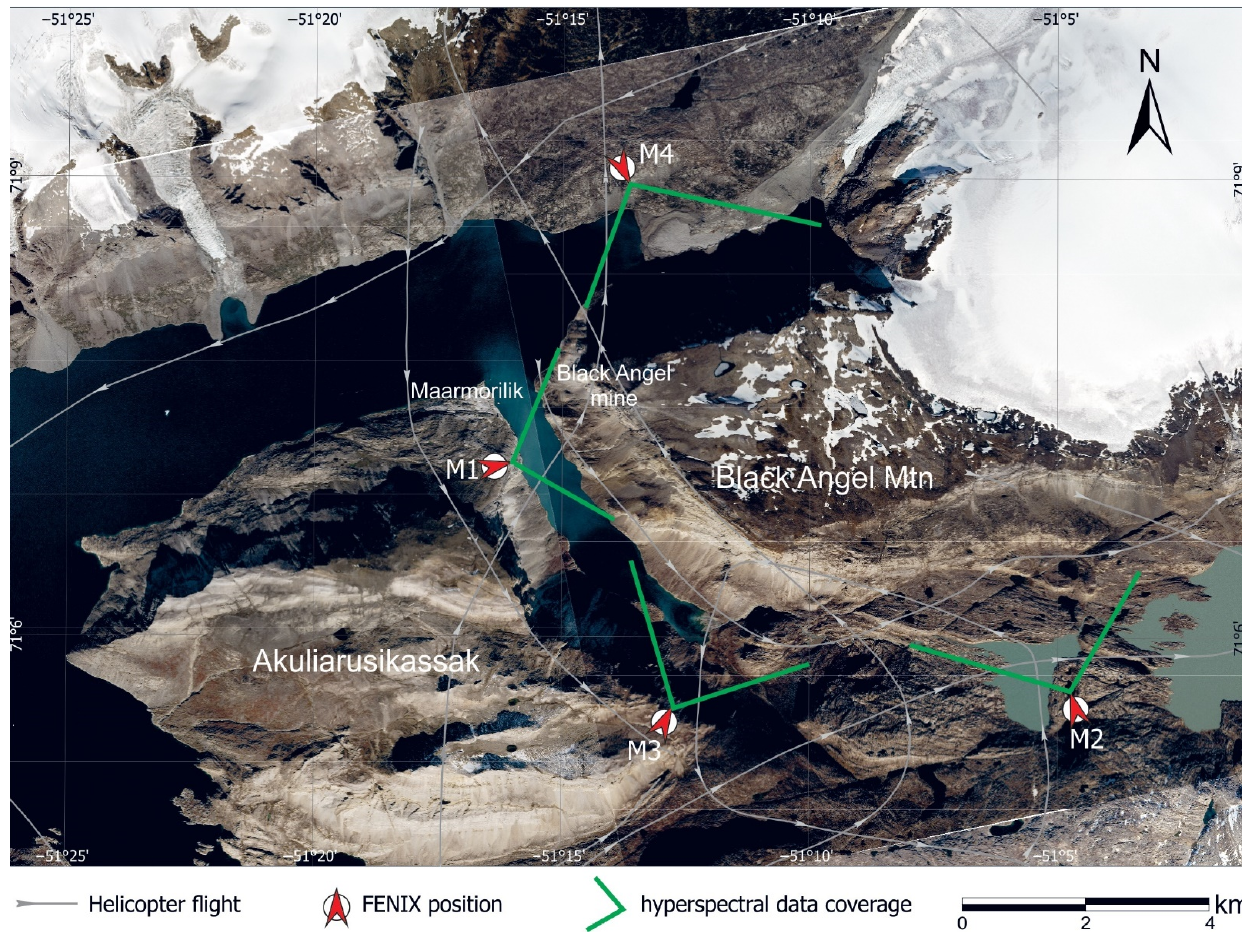
Figure 4. Helicopter flightlines and scanning positions of the hyperspectral camera showing the related data coverage of the investigation area.